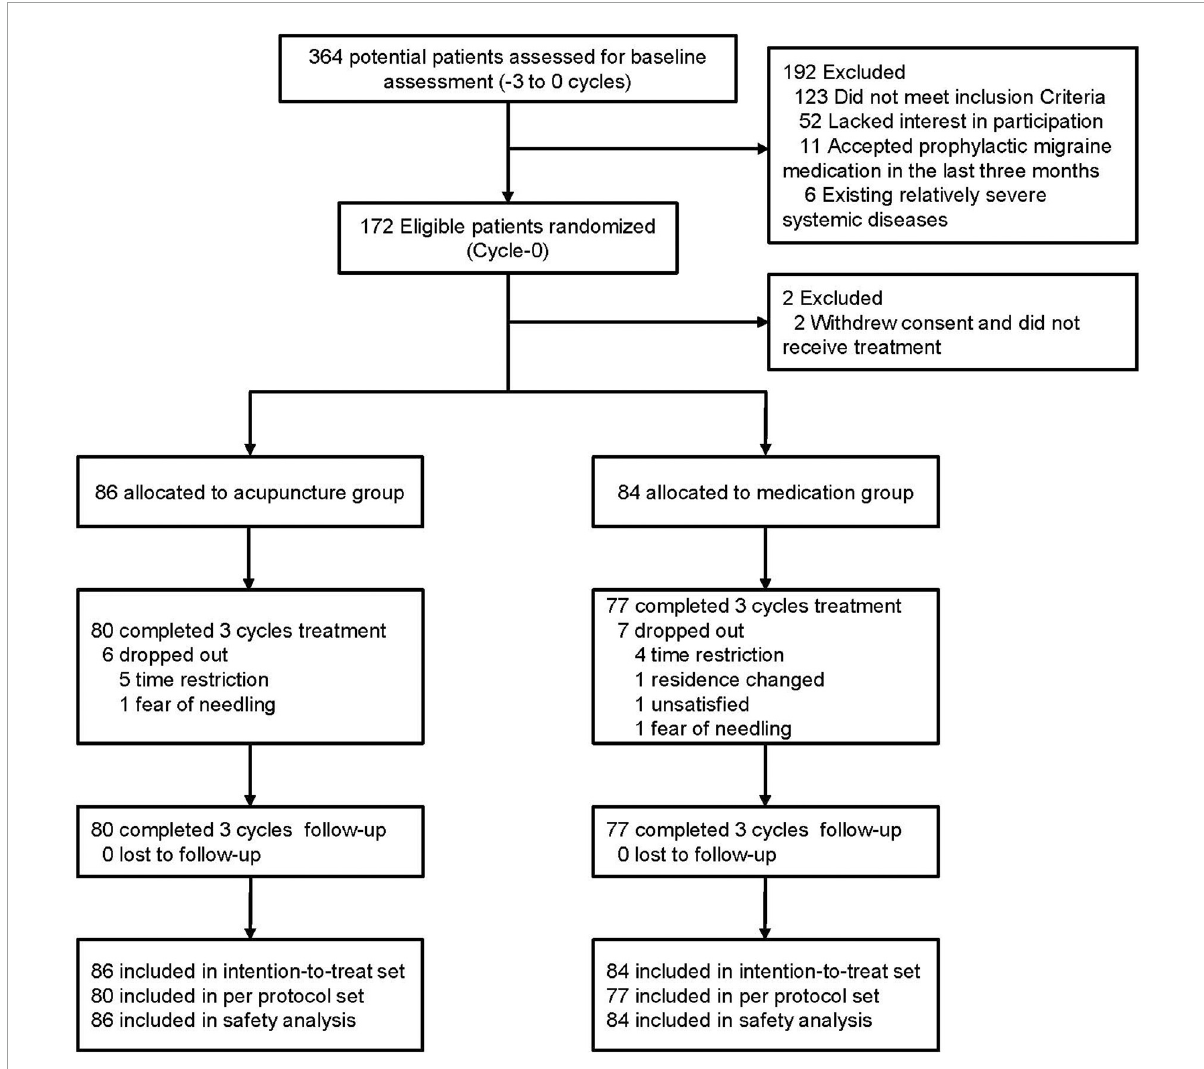
FIGURE1 Flowchart of the screening, enrollment, randomization, and follow-up of